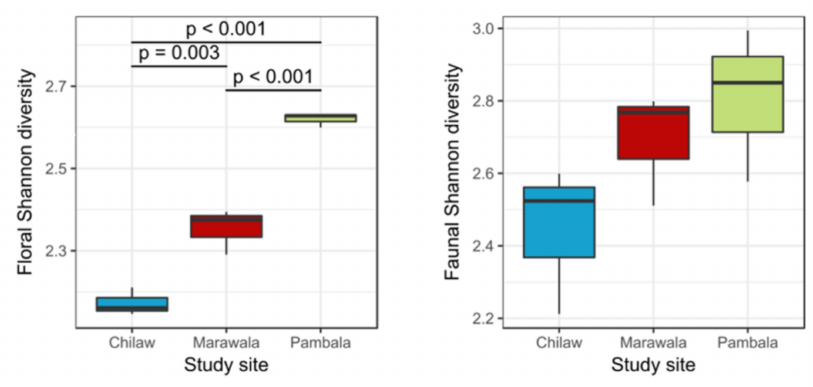
Figure 2. Mean Shannon diversity of the floral surveys ( left ) and the faunal surveys ( right ) of the three sites. p -values are given only for significant differences according to Tukey post-hoc test.